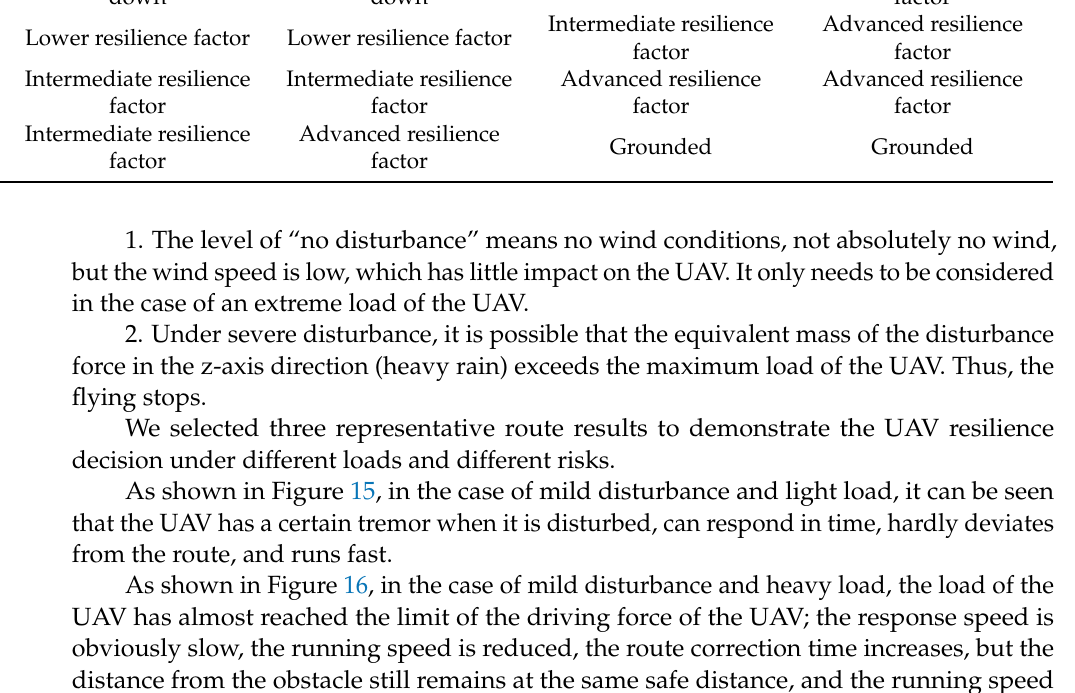
Table 3. Schematic representation of the degree of adjustment of the resilience system.